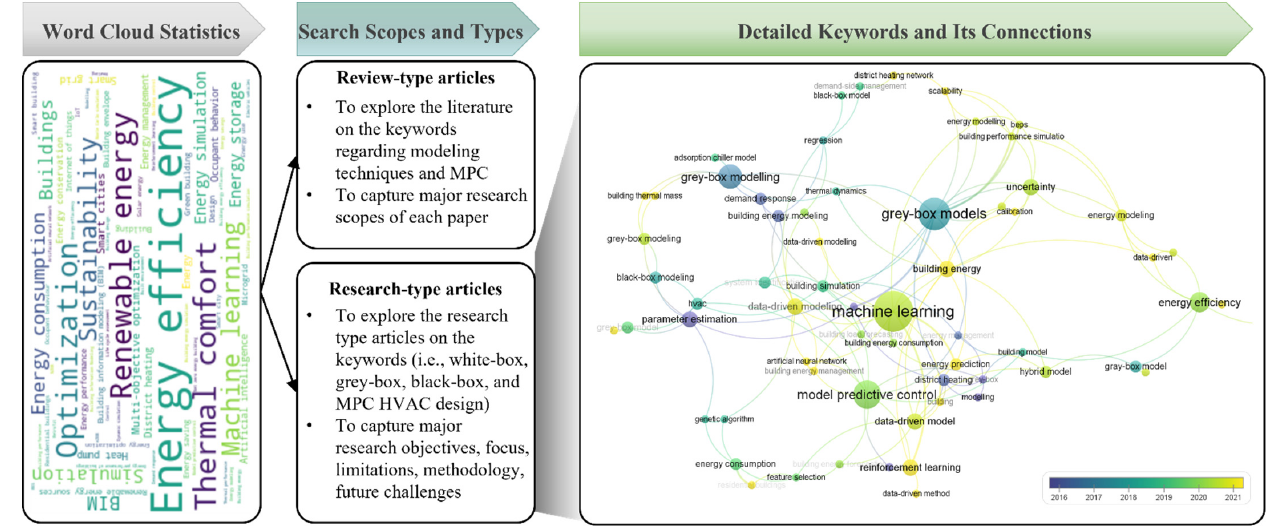
Figure 1. Review process workflow for HVAC energy modeling, control, and optimization in smart building applications.